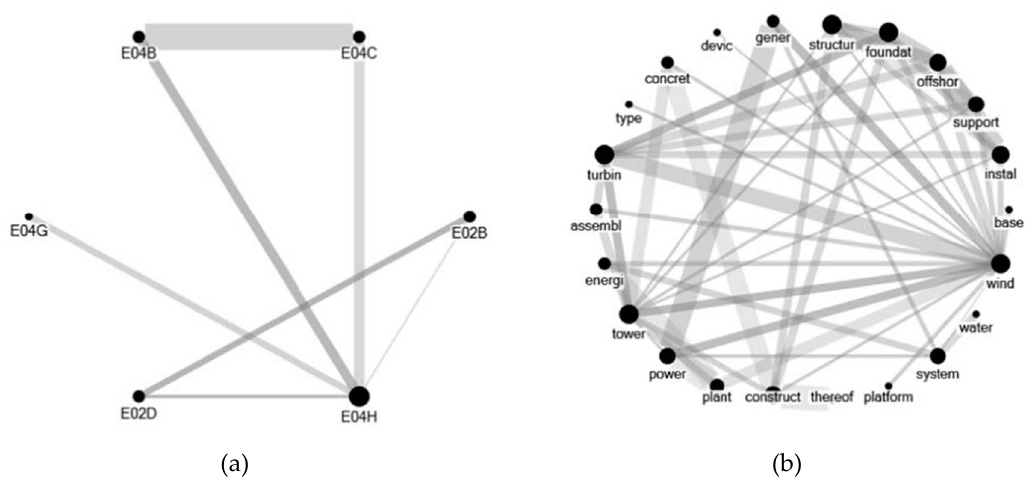
Figure 7. Other fields network graph to visualize ARM. ( a ) Other fields IPC Network; ( b ) Other fields Key Terms Network.